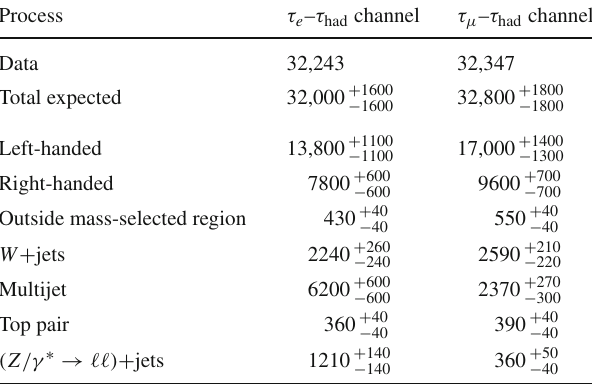
Table 4 Event yields expected in the selected signal region for both channels. The Z /γ ∗ → ττ contribution is shown separately for the three components used when extracting the polarisation in the 66– 116 GeV mass-selected region (see Sect. 5). The τ polarisation is assumed from the simulation for Z /γ ∗ → ττ events. Total uncer- tainties are